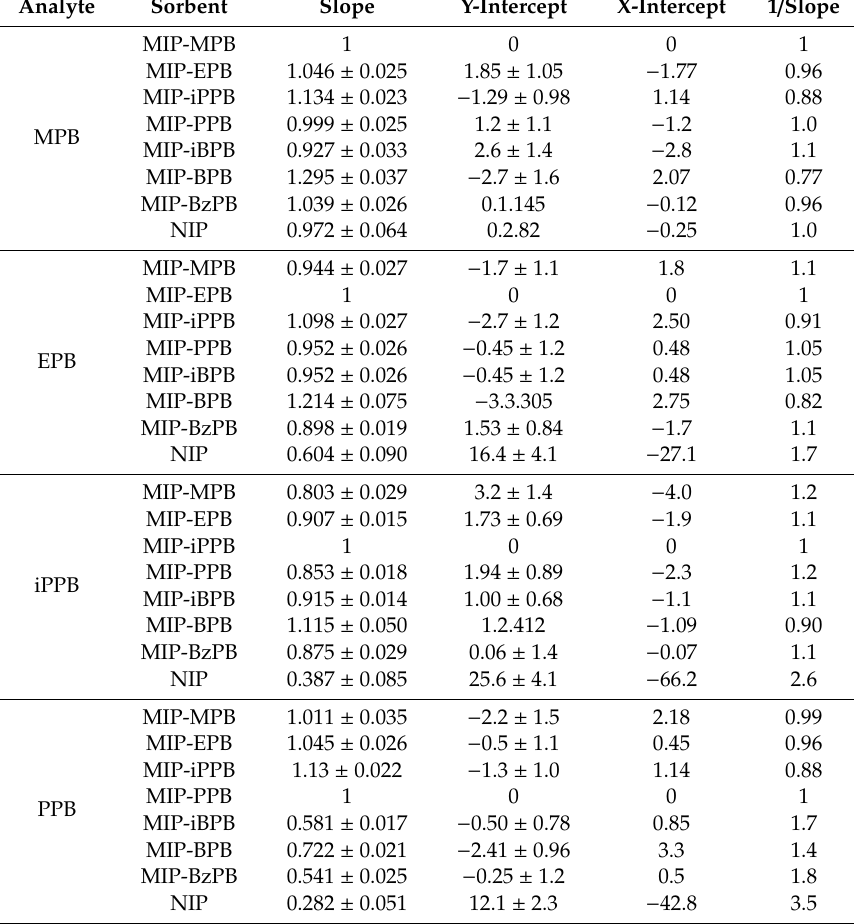
Table 3. Linear regression